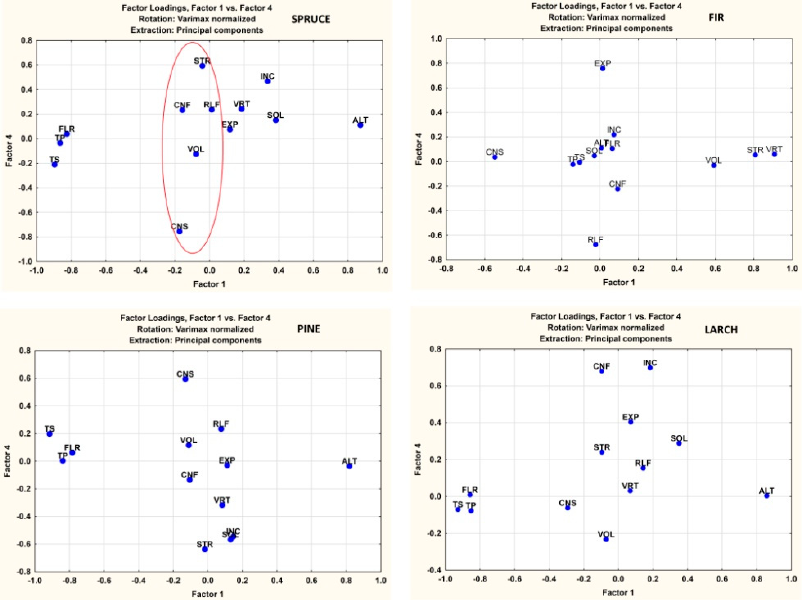
Figure 11. FA diagram for factors 1 and